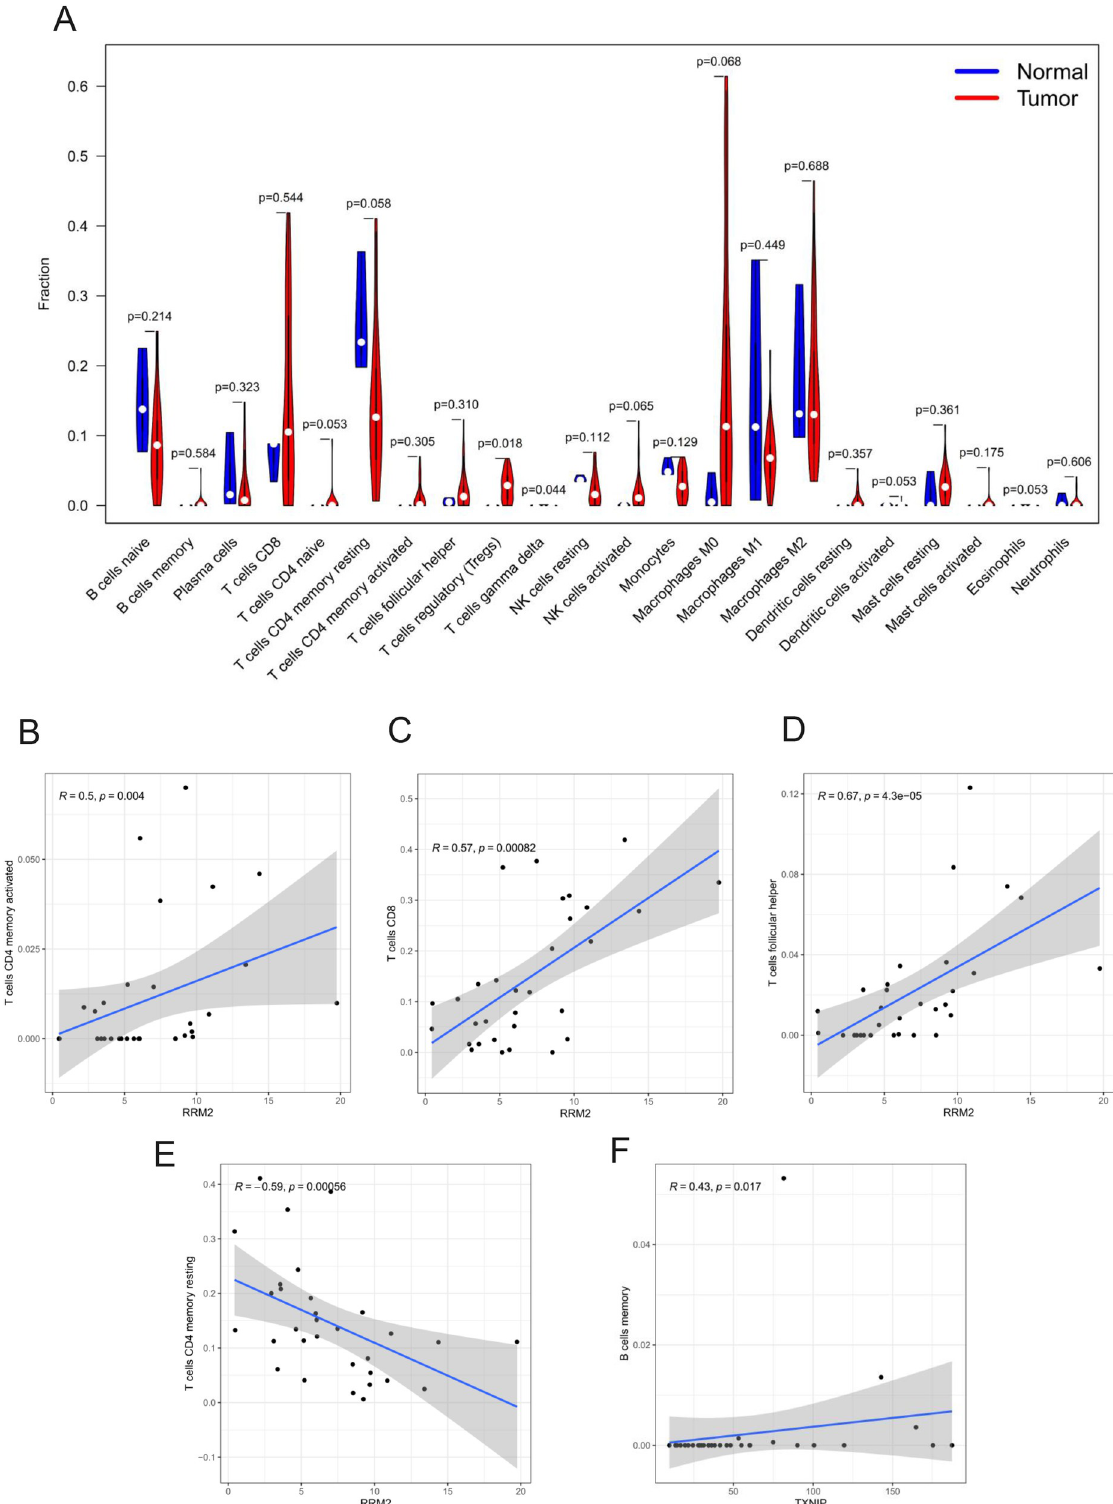
Fig 9. Correlation between HCC prognosis ceRNA network and immune cells. (A) Different proportions of immune cell subsets between normal and HCC liver tissues. Pearson correlations indicate that the expression of RRM2 has a positive correlation with T cells CD4